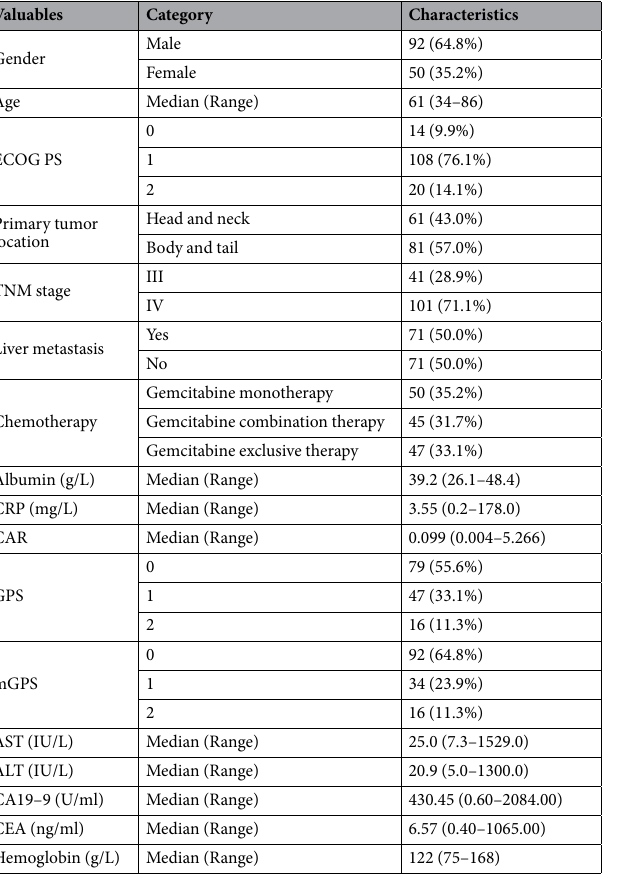
Table 1. Baseline clinicopathological characteristics of patients with